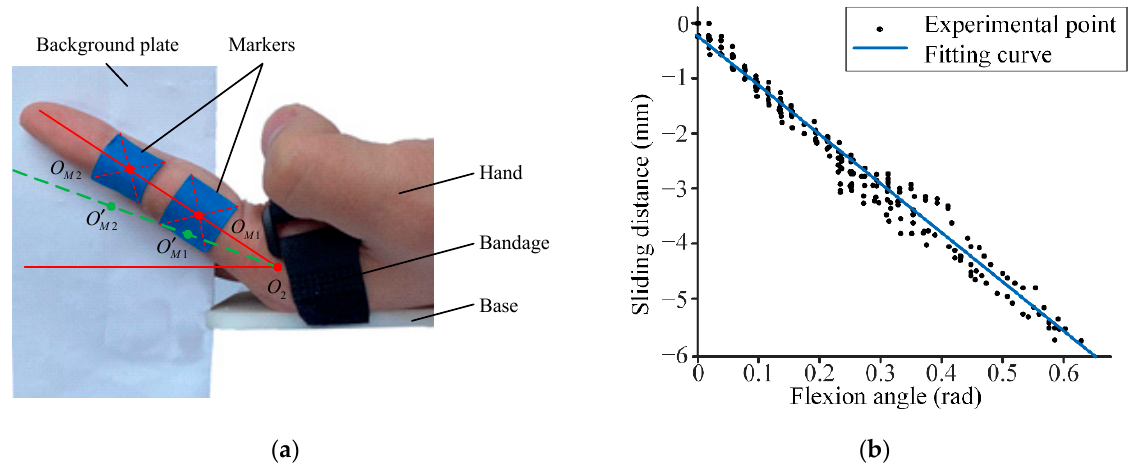
Figure 1. The diagram of ( a ) the position of the markers pasted onto subject and ( b ) the proximal phalanx sliding distance variation for different flexion angles of MCP joint.